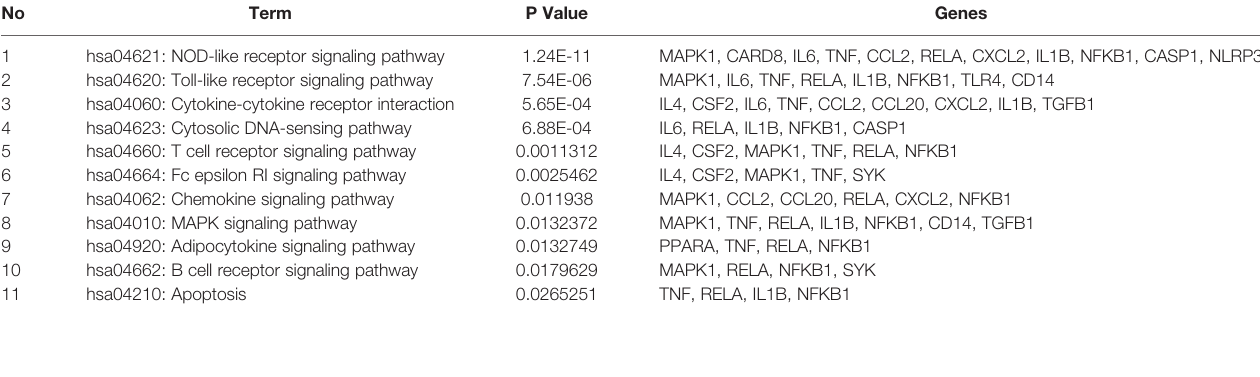
TABLE 2 | Functions of potential target genes based on KEGG pathway analysis.